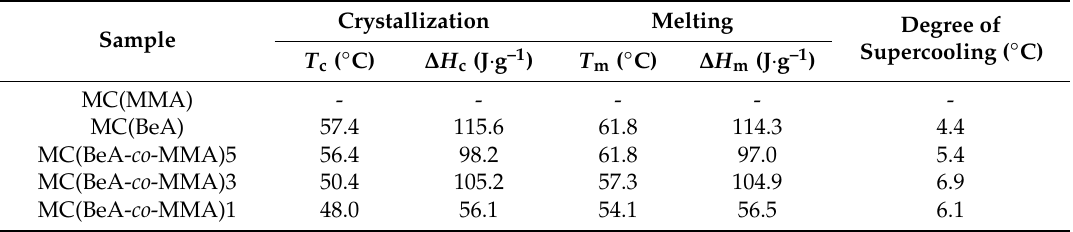
Figure 2. DSC curves of MC(BeA- co -MMA) copolymer microcapsules and MC(BeA) in the cooling process measured at a cooling rate of 5 °C·min –1 . Table 2. Thermal properties of MC(BeA) and MC(BeA- co -MMA) copolymer microcapsules with different monomer ratios, measured at a temperature changing rate of 5 °C·min − 1 .